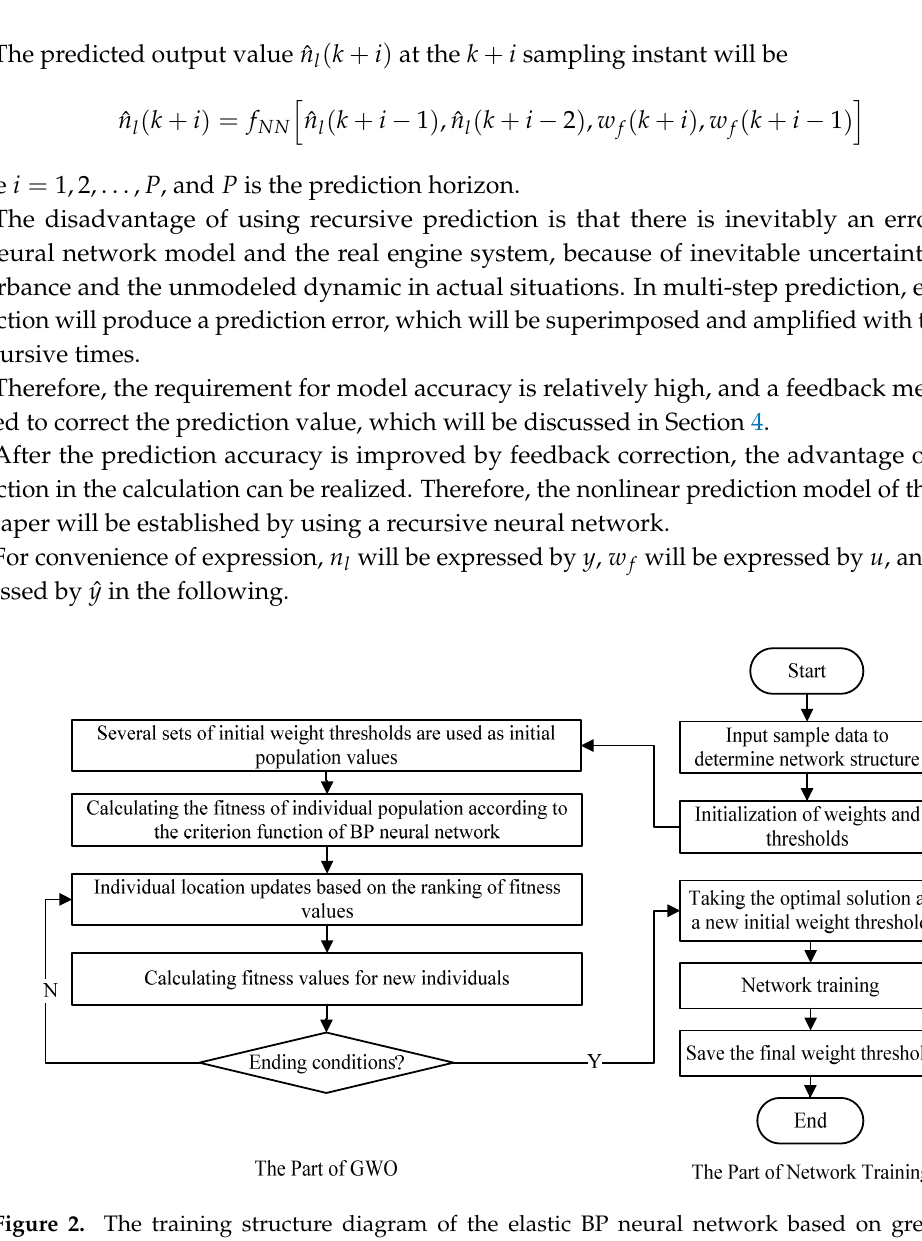
Figure 2. The training structure diagram of the elastic BP neural network based on grey wolf optimization (GWO) (GWO-EBPNN).